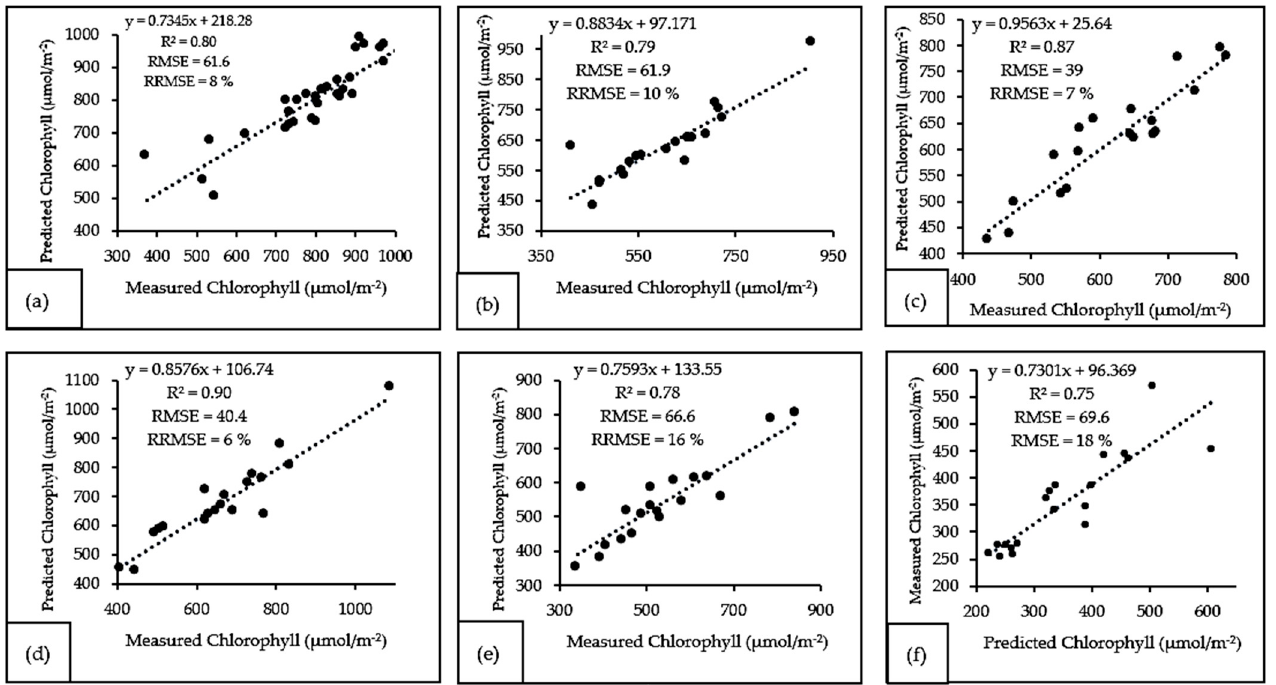
Figure 5. Linear relationships between measured and predicted maize chlorophyll content for veg- etative stages ( a ) V5–V10, ( b ) V12, ( c ) V14 to VT, and reproductive stages ( d ) R1–R3, ( e ) R3–R4, ( f